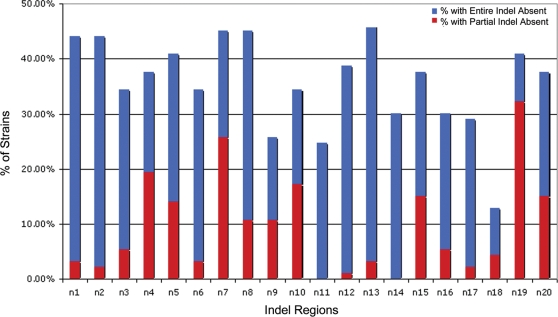
Frequency of Indels in Bp.The graph shows the percentage of strains exhibiting either a partial (red) or total (blue) absence of the indel segment (n1–n20). Blue represents the percentage of strains where the entire indel is absent. Red represents strains where the indel is only partially absent.